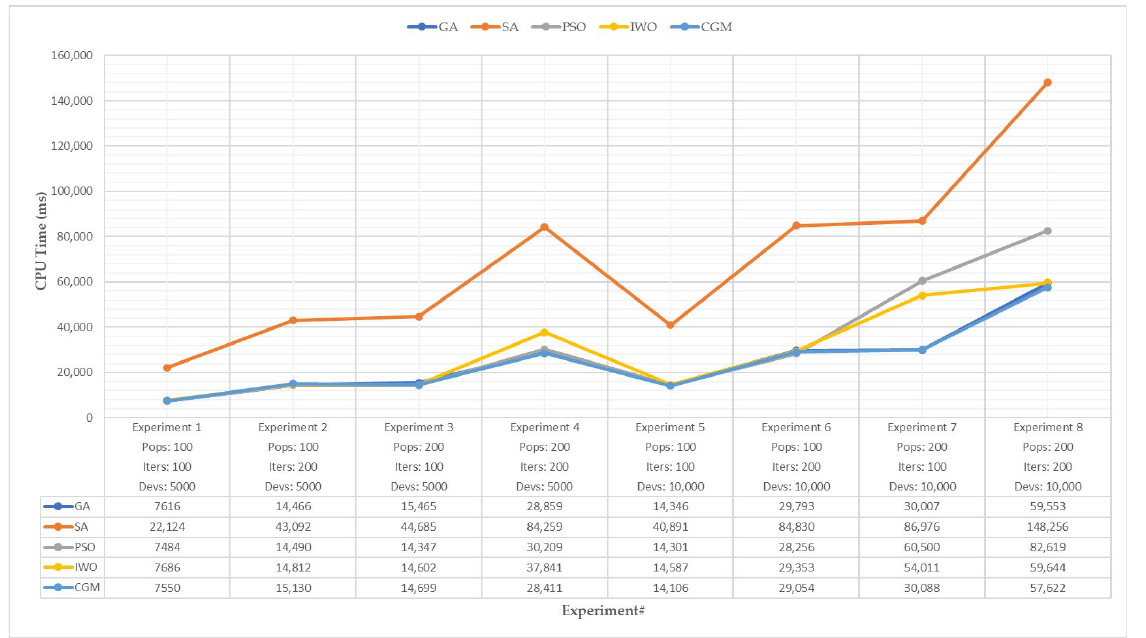
Figure 19. Evaluation results of execution time (CPU time) criterion for the optimal-placement-of- resources problem with large parameters (in milliseconds)